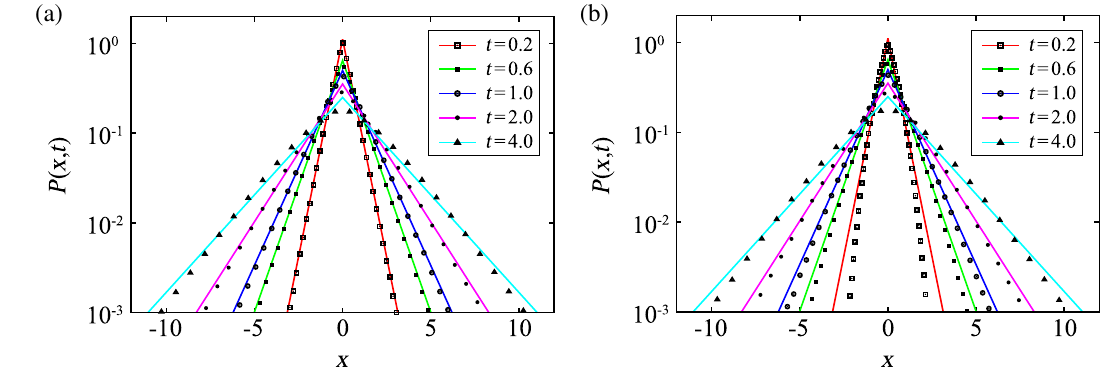
FIG. 3. Short-time diffusive properties of the EPK model Eq. (40). All model and simulation parameters are given in the text. Shown is the position probability density function P ð x; t Þ for the transition rates λ ¼ f 10 ; 10 2 g [(b) and (a), respectively]. Symbols correspond to the results of stochastic simulations at increasing values of time t as given in the legends. Lines represent the Laplace distribution Eq.